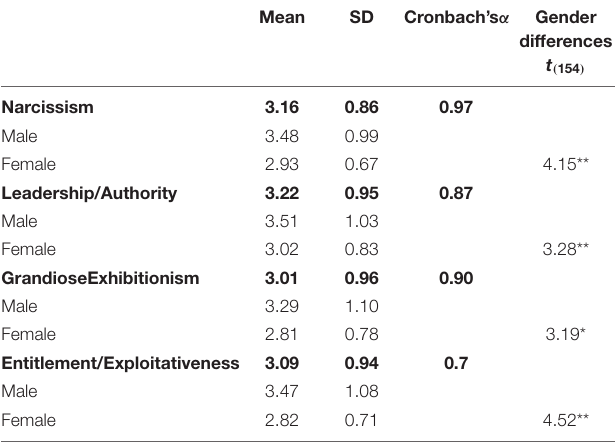
TABLE 6 | Means (and SDs) of rational and experiential rational-experiential TABLE 5 | Means and SDs of narcissistic features separated for male and inventory (REI) scales separated for male and female participants. female participants. Mean SD Cronbach’s α Gender N Rational differences